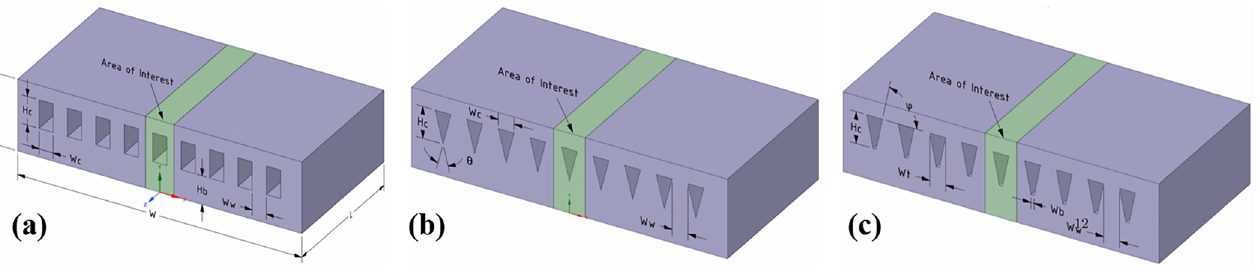
Figure 4. 3D models of different channel cross-section shapes [88]: ( a ) rectangular channel; ( b ) triangular channel; ( c ) trapezoidal channel.